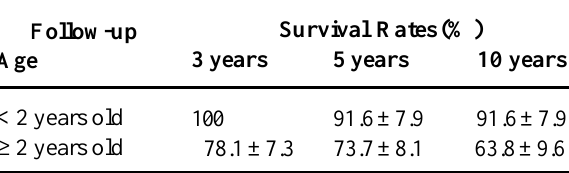
Table 4 – Disease-free survival rates according to child age and time of follow-up.